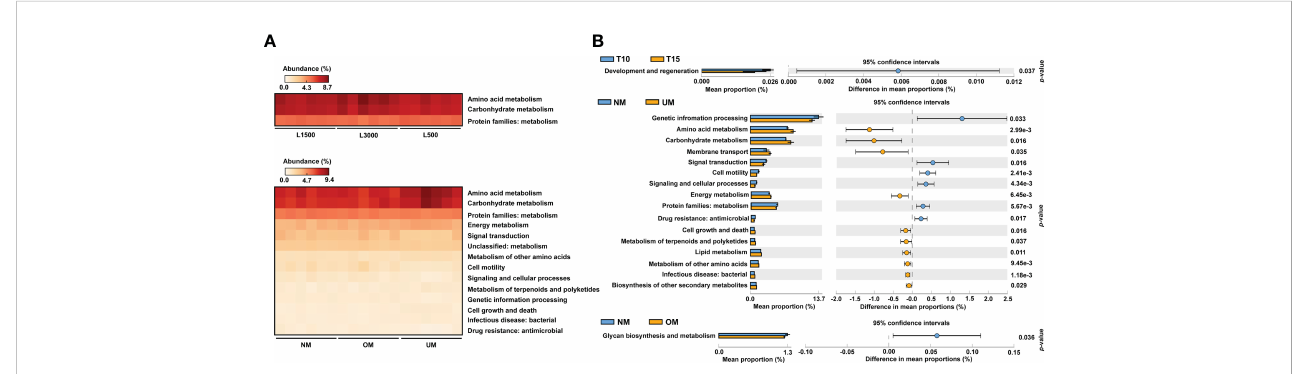
FIGURE 5 Comparisons of predicted functional pro fi les among treatment groups (A) and between groups with signi fi cantly different MD severity (B) . Signi fi cant differences were determined based on relative abundance using ANOVA ( p < 0.05, Tukey post-hoc test) and Welch ’ s t -test ( p < 0.05),